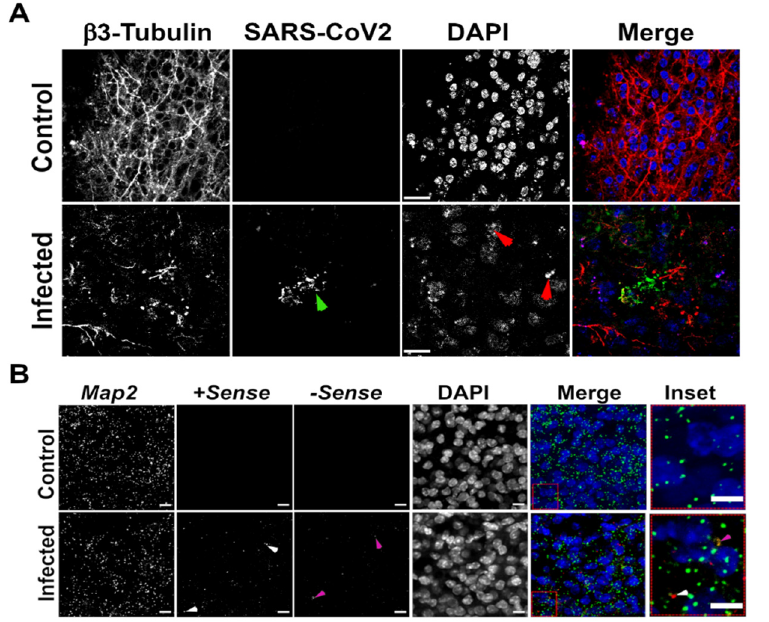
Figure 3. SARS-CoV-2 does not infect neurons in a hamster brain cerebellar slice culture. Repre- sentative images of hamster brain cerebellar slices labelled to visualize ( A ) β 3-tubulin (red) and SARS-CoV-2 nucleocapsid (green) by indirect immunofluorescence or ( B ) neuronal ( Map2 ; green) and SARS-CoV-2 markers by RNA ISH. Nuclei were counterstained with DAPI (blue). Merge is a composite of all individual images. Arrowheads identify either viral nucleocapsid protein (green; ( A )), +sense (white; ( B )) or -sense (magenta; ( B )) viral RNA strands indicating areas of active infection and replication respectively. The red arrowheads ( A ) indicate fragmenting nuclei and blebbing, surrogate markers for apoptosis. Scale bar = 10 β